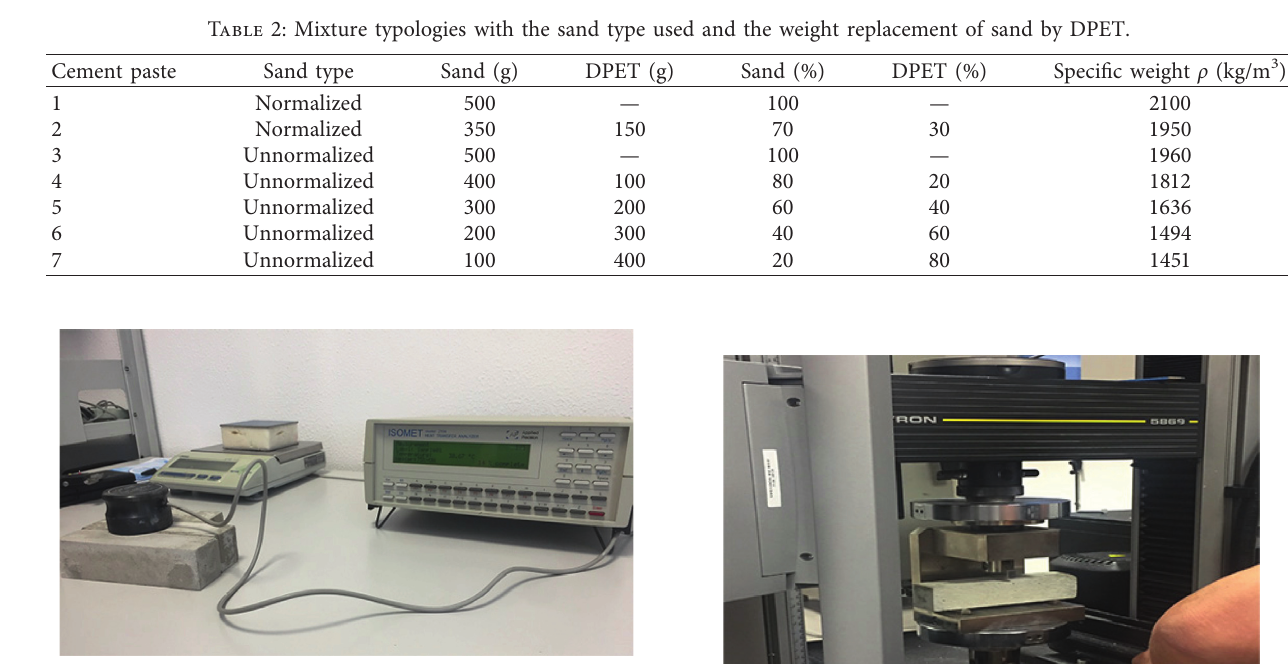
Figure 2: Conductivity test device.